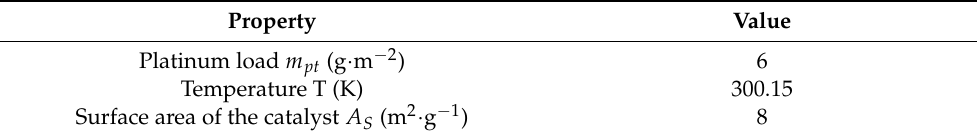
Table 6. Values used for the alternative exchange current density formulation.